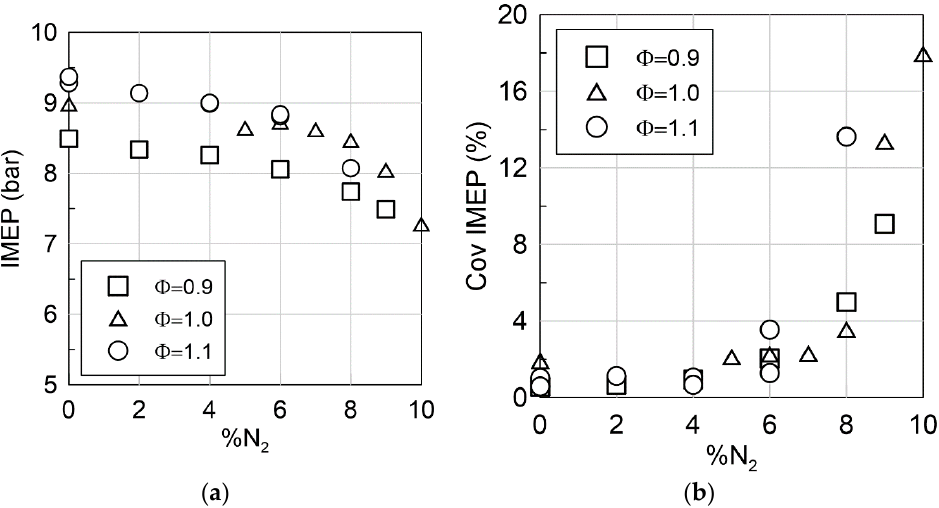
Figure 9. IMEP ( a ) and COV IMEP ( b ) vs %N 2 in total intake gases for pure ammonia, P in = 1.3 bar, 1500 rpm.